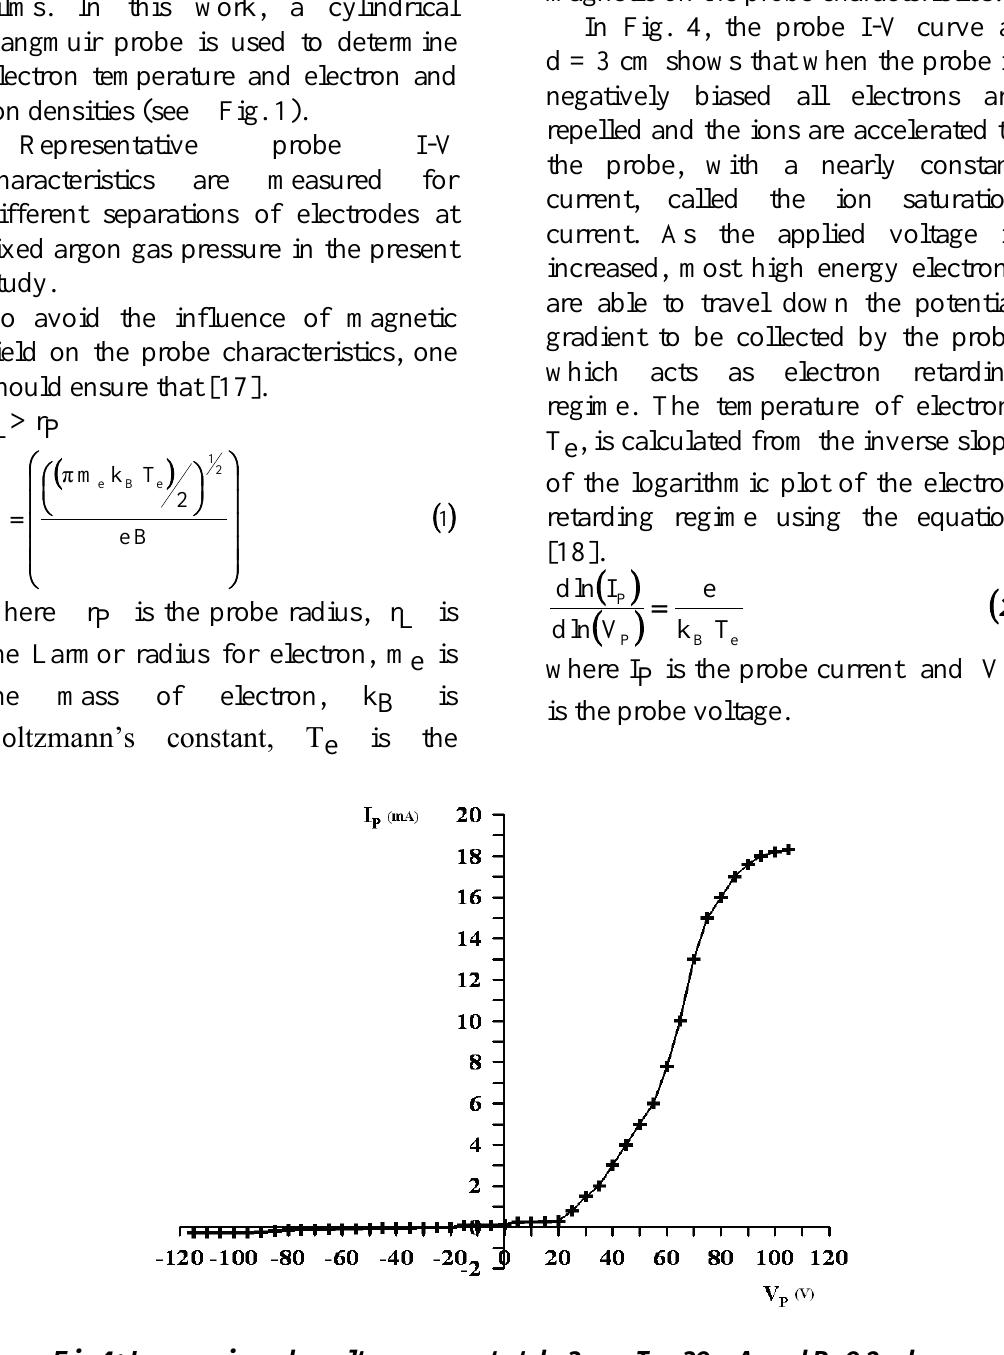
Fig.4: Langmuir probe voltage-current at d= 3 cm, Id =30 mA and P=0.2